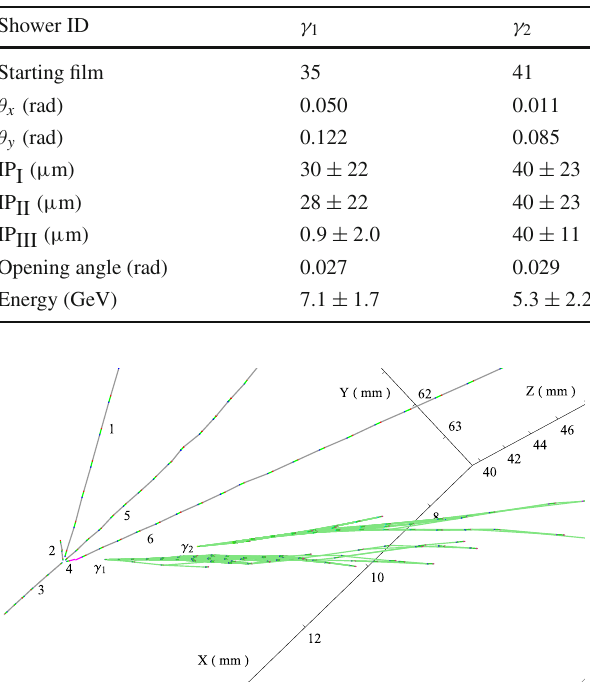
reconstruct the electromagnetic showers [22]. An additional image data taking with 1 micron Z pitch is performed in a cone of 400 mrad aperture around the slope of the primary photon ( e + e − mean slope), starting from film 31 down to film 57 in the brick. All tracks in the volume are reconstructed using the 3D clustering algorithm. The main features of the reconstructed showers are listed in Table 3 and shown in Fig. 6. The most downstream shower tracks are reconstructed in the CS films. Given the accuracy of the reconstruction, γ 1 is most probably attached to V I I I , while γ 2 may emerge from any vertex ( V I , V I I or V I I I ), see IPs in Table 3. In the next